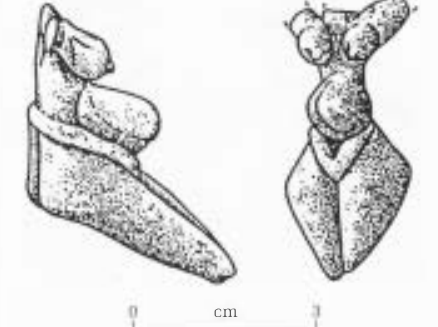
Figure 6 A terracotta female figurine from Ter Kala Dheri showing elements (pregnancy and pendulous breasts) char­ acteristic of Sheri Khan Tarakai types, combined with the typical morphology of Early Bronze Age types known from sites such as Rehman Dheri, Lewan and Lak Largai.